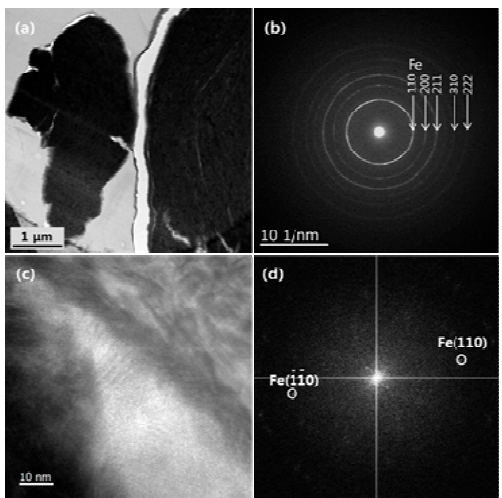
Figure 2. TEM (Transmission Electron Microscopy) analysis results of the mechanically alloyed Fe-10Cr-5Y 2 O 3 powders: ( a ) TEM image, ( b ) SAD (Selected Area Diffraction) pattern, ( c ) HRTEM (High Resolution Transmission Electron Microscopy) image, and ( d ) FFT (Fast Fourier Transformation) pattern.